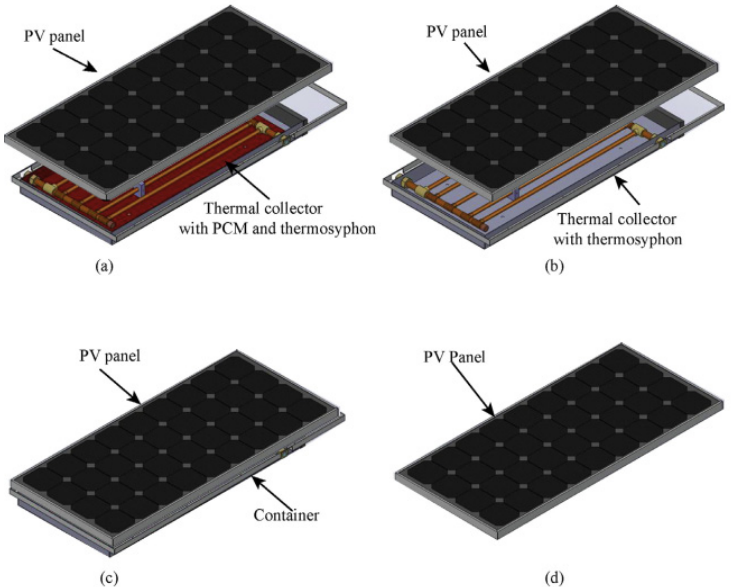
Figure 15. Diagram of the different designs: ( a ) PV/T/PCM, ( b ) PV/T, ( c ) PV with container, and ( d ) PV, studied by Browne et al. [47]. Adapted with permission from Elsevier.